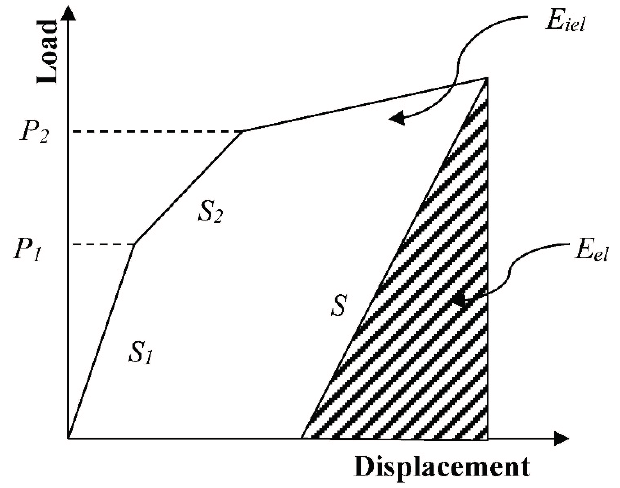
Figure 4. Evaluation method of elasticity